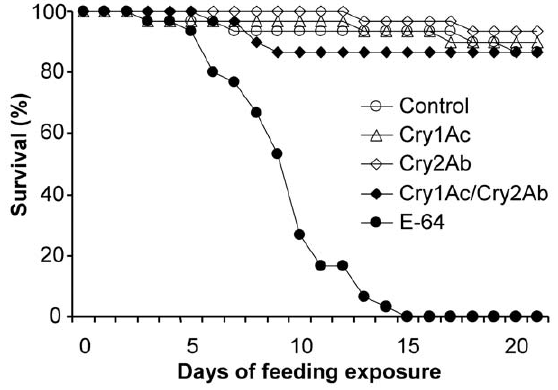
Figure 3. Survival of Coleomegillamaculata fed pure artificial diet or diet containing insecticidal protein. Per g dry weight, 100 m g Cry1Ac, 400 m g Cry2Ab, 100 m g Cry1Ac and 400 m g Cry2Ab, or 150 m g E-64 (positive control) were incorporated. Pure diet served as a negative control. (N=30). doi:10.1371/journal.pone.0022185.g003 PLoS ONE |